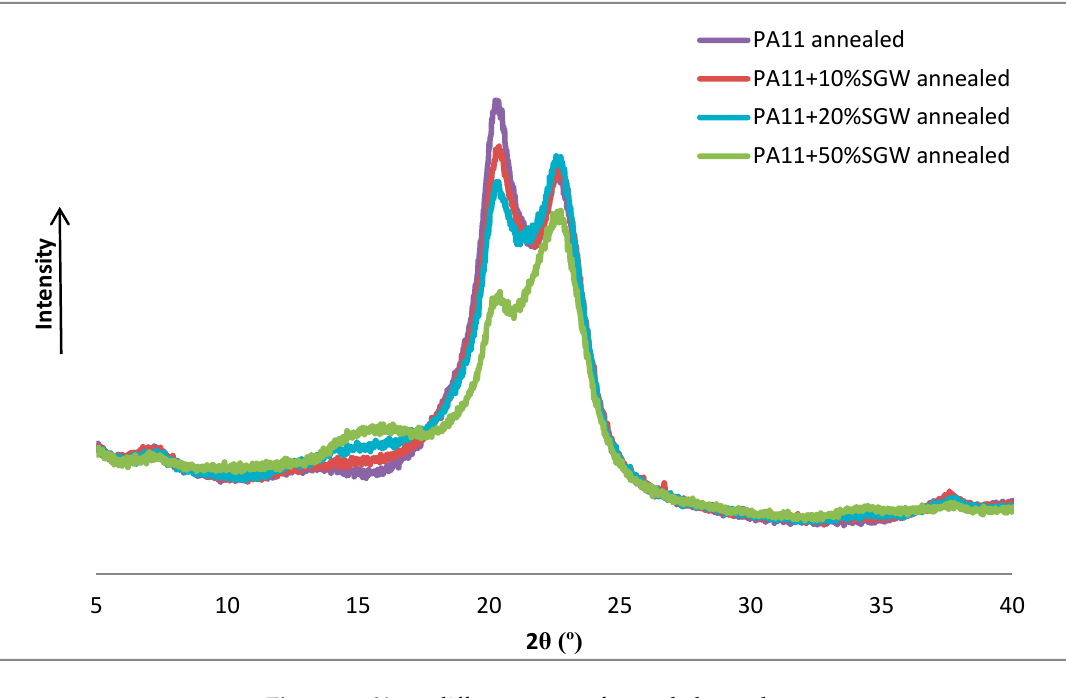
Figure 11. X-ray diffractograms of annealed samples.